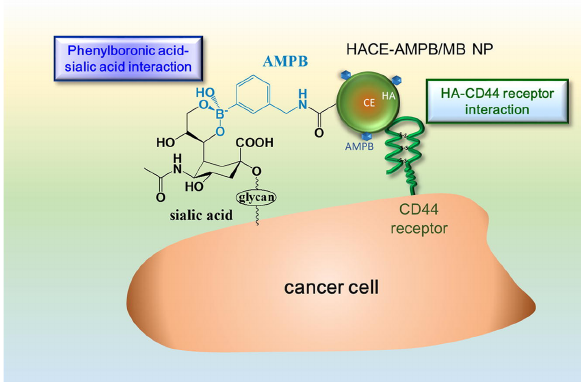
Figure 16: The tumor targeting and penetration strategy using HACE- AMPB/MB nanoparticles. Reprinted with permission from